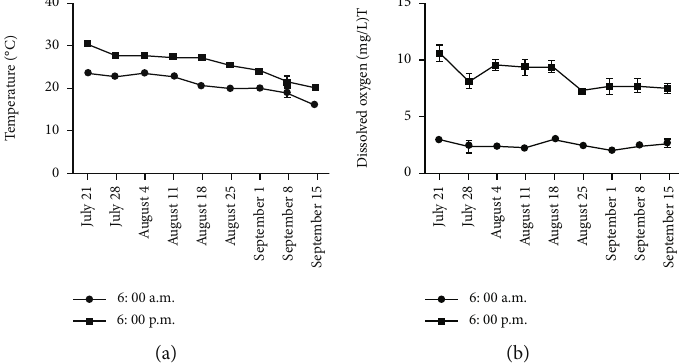
6: 00 a.m. 6: 00 Figure 2: Changes of temperature and dissolved oxygen content in the rice fi eld during E. sinensis culture. Note: the abscissa represents the monitored date of temperature and dissolved oxygen content. Temperature and dissolved oxygen content were monitored once a week. The data are represented as the mean ± standard deviation ( n = 3